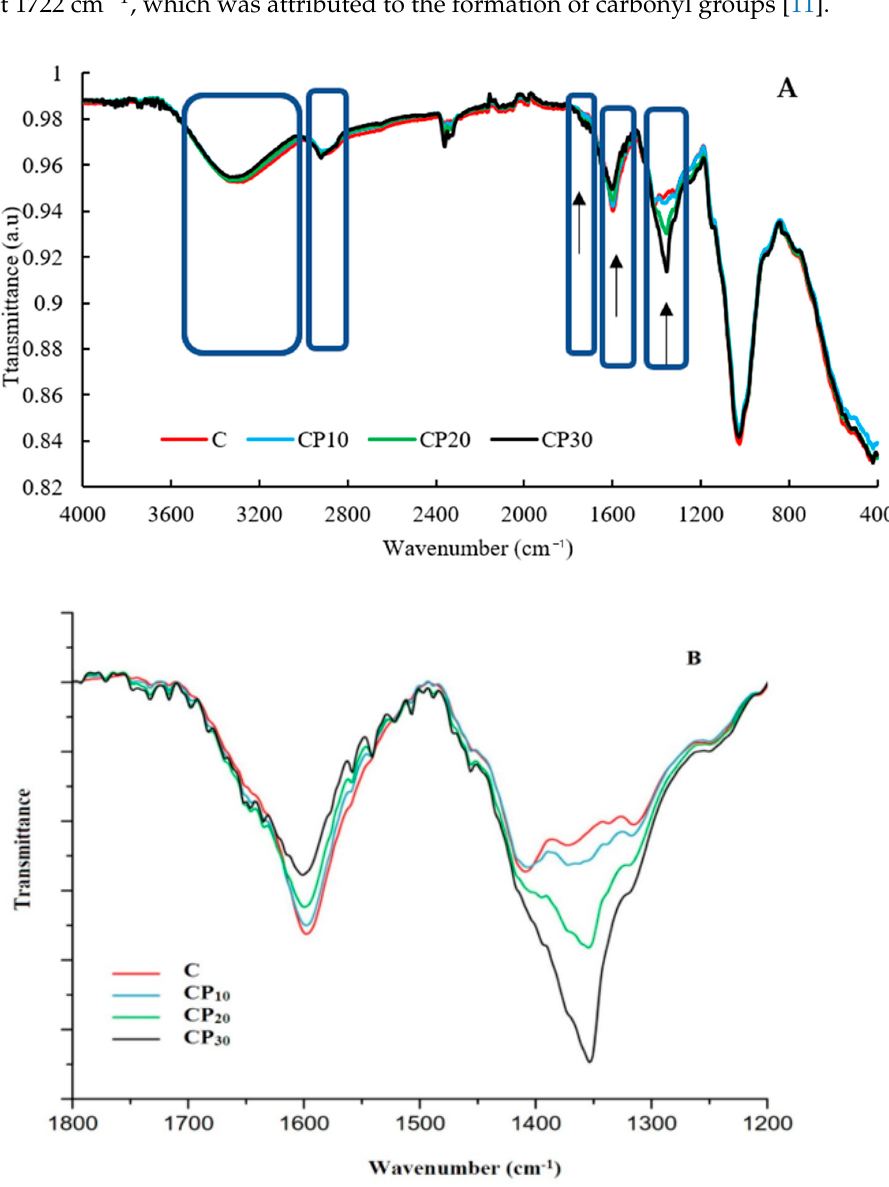
Figure 2. FT-IR spectra of different BSG samples at 4000–400 cm − 1 ( A ) and 1800–1200 cm − 1 ( B ); C, CP 10 , CP 20 , and CP 30 indicate unmodified samples and those treated by CP for 10, 20, and 30 min, respectively.